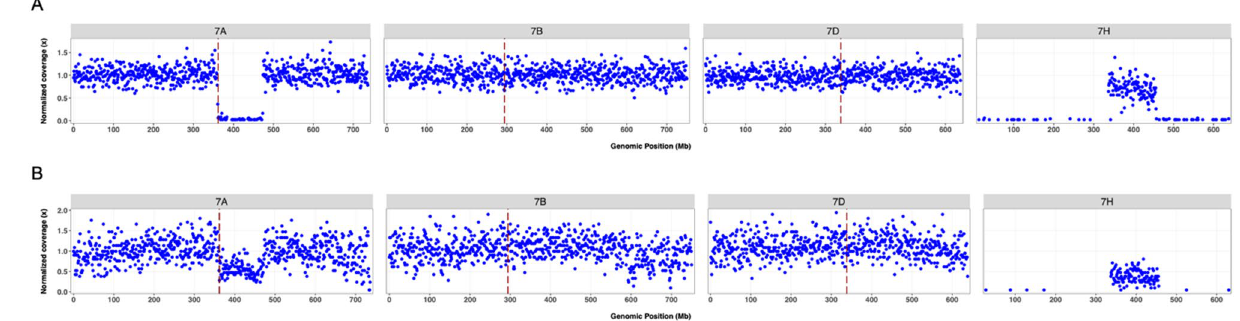
Figure 3. Normalized read counts of a wheat-barley group 7 translocation (7AS.7HL-7AL) for ( a ) homozygous parent TA5798 [tissue id: DNA191014P04_B11] and ( b ) heterozygous back-cross derived wheat-barley progeny [tissue id: DNA191014P01_G11]. The dashed vertical lines indicate the position of wheat centromeres based on the IWGSC RefSeq v1 assembly 49 .